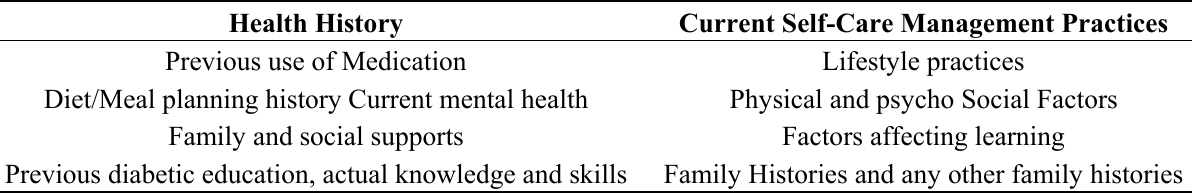
Table 1. Comprehensive Educational